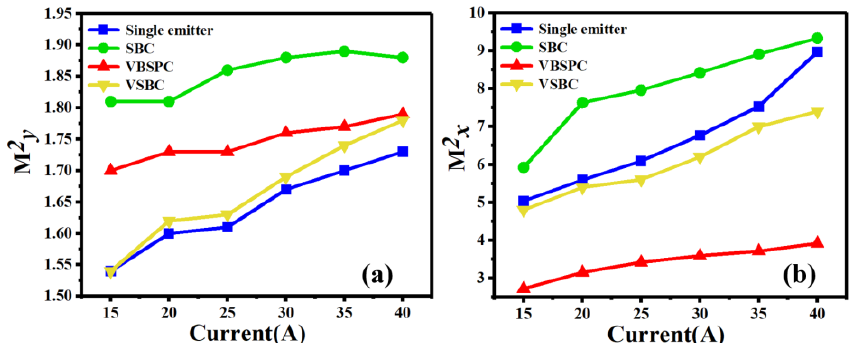
Figure 4. The dependence of M 2y ( a ), M 2x ( b ) factors of VBSPC (red), SBC at an OC with reflectivity of 33% (green), VSBC (yellow), and single emitter (blue) on current.